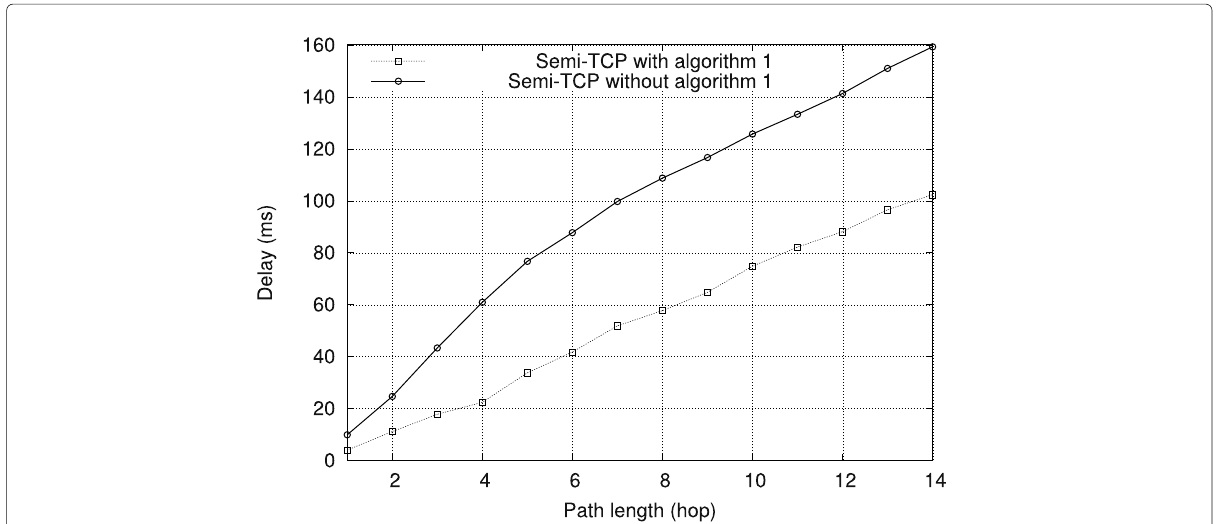
Fig. 8 End-to-end throughput in the chain